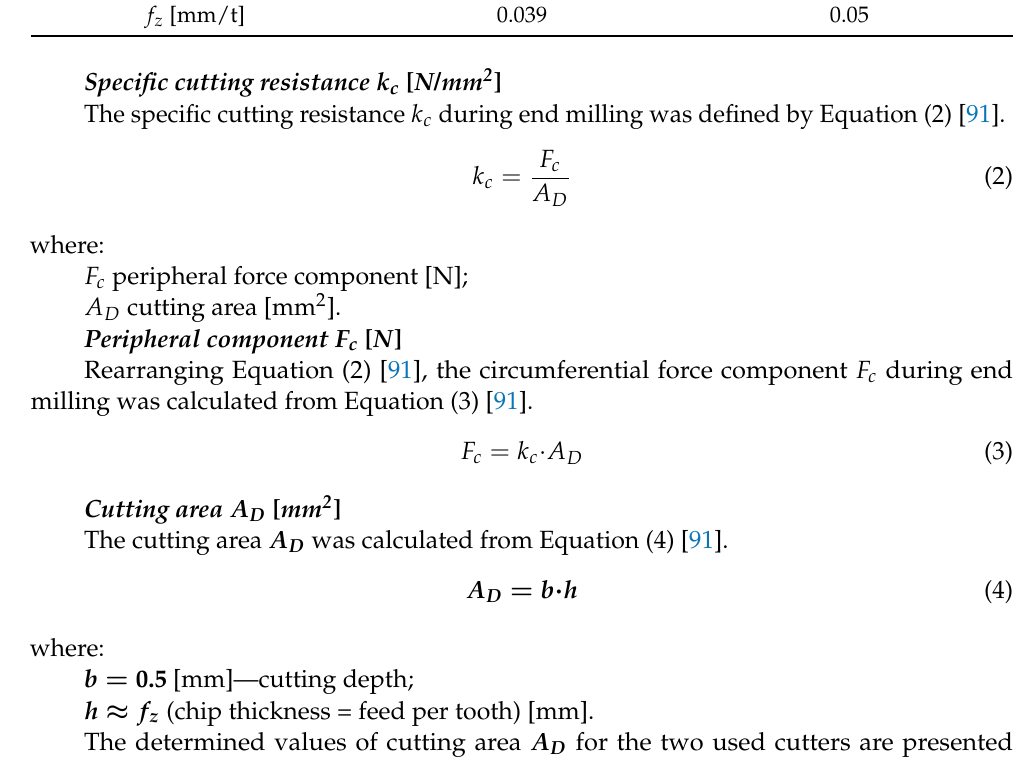
Table 2. Values of feed per tooth f z for the course and finishing milling cutter. Parameter